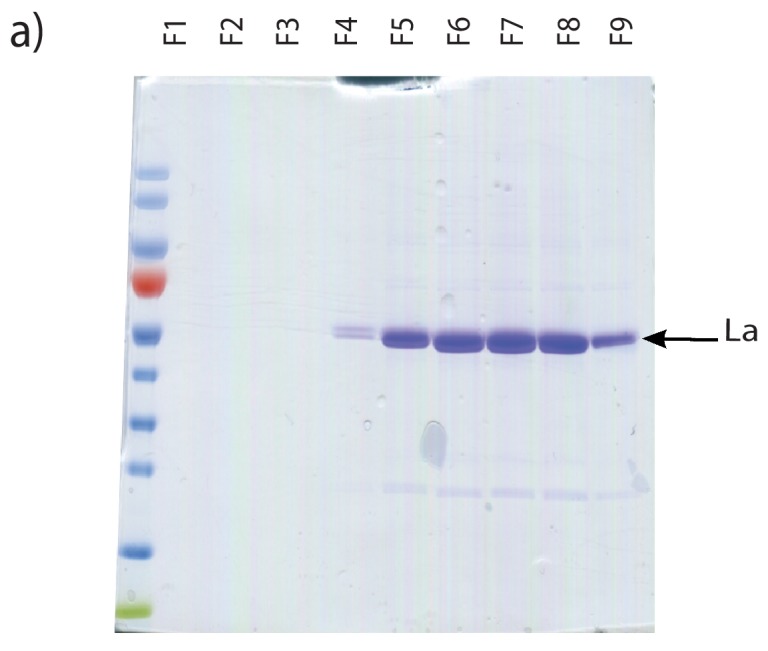
Purification of heterologously expressed La.Coomassie staining of purified La fractions. Fractions shown were collected post gel filtration on Sephadex G25 columns.